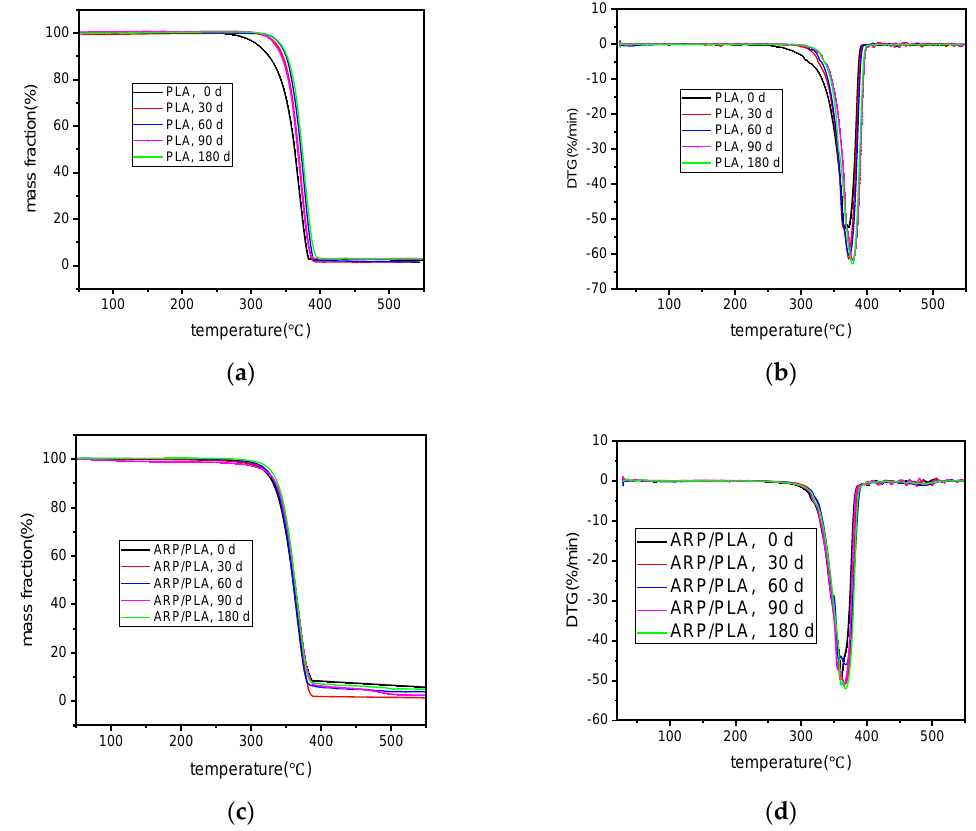
Figure 9. TG – DTG curves of different samples in different degradation periods: ( a ) TG curves of PLA; ( b ) DTG curves of PLA; ( c ) TG curves of ARP/PLA; ( d ) DTG curves of ARP/PLA. Table 1. Thermogravimetric analysis information for different specimens.